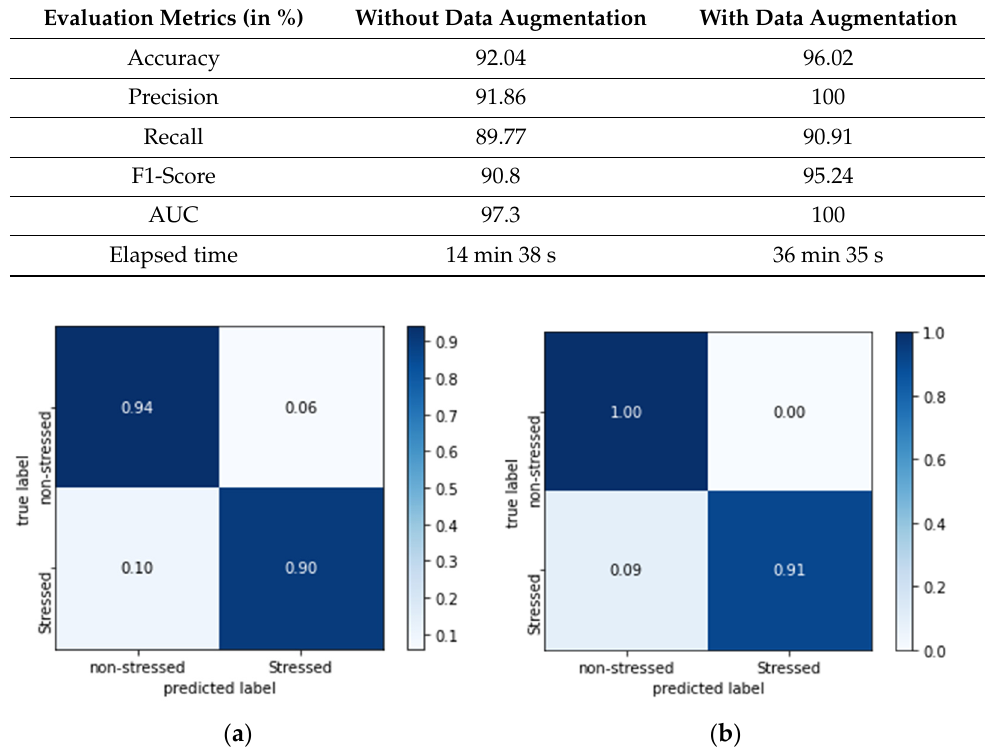
Figure 12. The confusion matrices for the combination of the best-performing signal segment (5 s) and optimizer (RMSprop) ( a ) before and ( b ) after data augmentation.